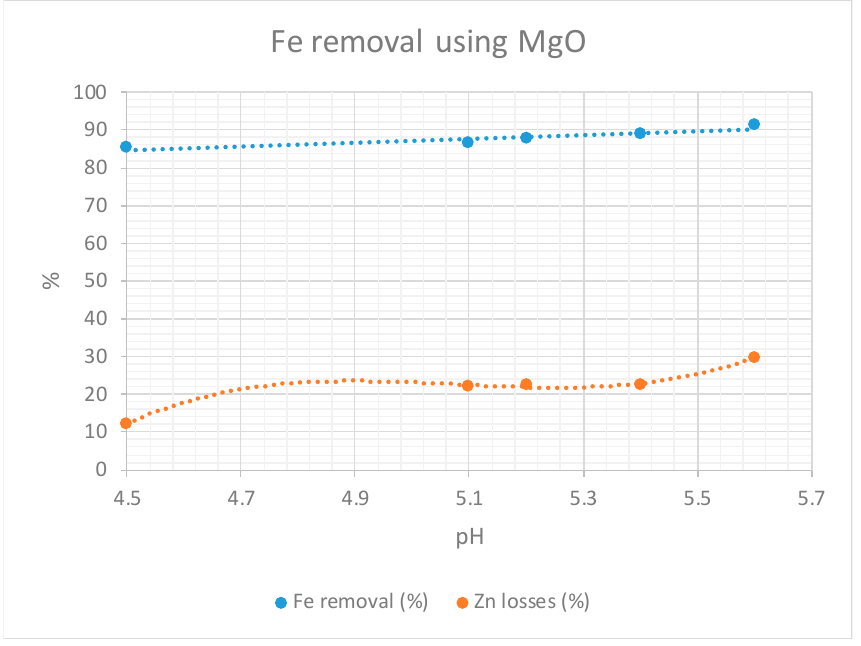
Figure 4. Exploratory test results using MgO.